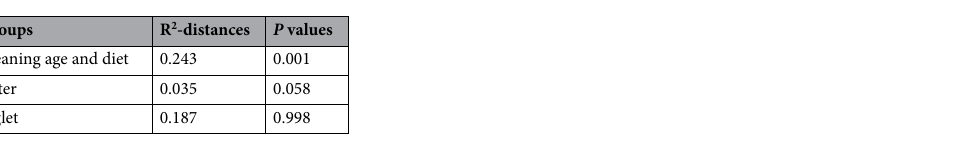
Table 2. Adonis results for gut microbiome in piglets from day 3 pre-weaning to day 8 post-weaning.